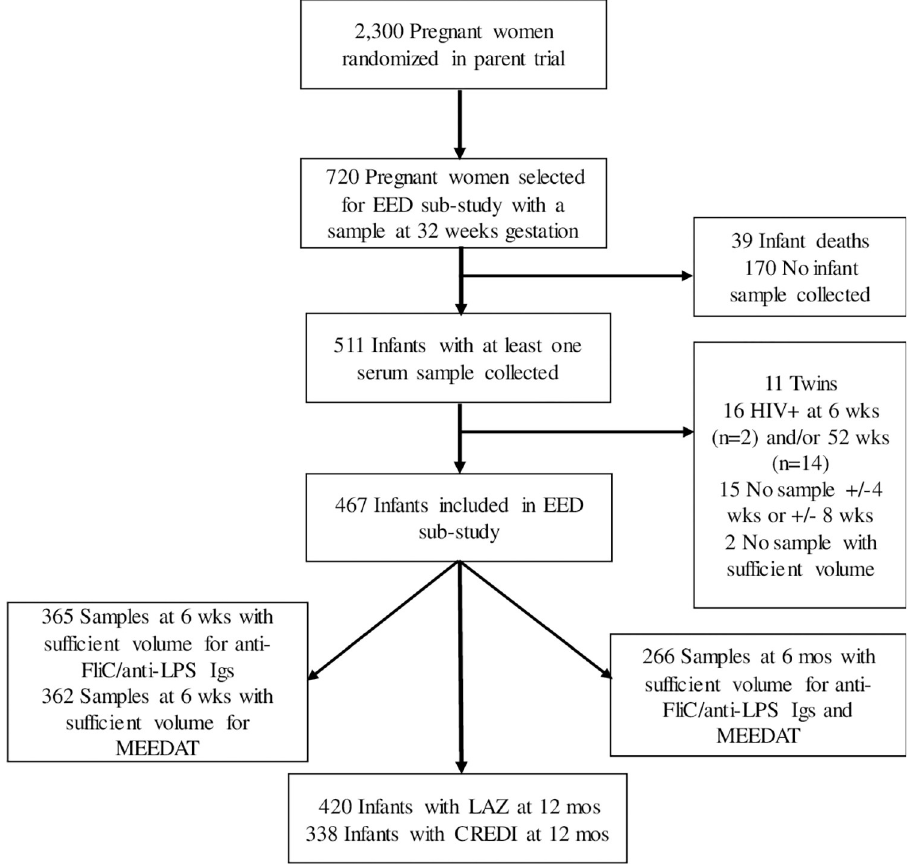
Fig 1. Flow diagram for study. Abbreviations: CREDI, Caregiver Reported Early Development Instruments; EED, environmental enteric dysfunction; FliC, flagellin; Ig, immunoglobulin; LAZ, length-for-age z-score; LPS, lipopolysaccharide; MEEDAT, Multi-Micronutrient and Environmental Enteric Dysfunction Assessment Tool Correlations among anti-flagellin and anti-LPS Igs were generally high, ranging from 0.736 between anti-flagellin IgG and anti-LPS IgG (p < 0.001) to 0.098 between anti-flagellin IgG and anti-LPS IgA at 6 weeks and from 0.853 between anti-flagellin IgA and anti-LPS IgA (p < 0.001) and 0.274 between anti-flagellin IgG and anti-LPS IgA (p < 0.001) at 6 months. MEEDAT’s EED biomarkers, sCD14 and I-FABP, were moderately correlated with each other (0.367, p < 0.001 at 6 weeks and 0.436, p < 0.001 at 6 months); sCD14 was also moderately correlated with the systemic inflammation markers, CRP (0.367, p < 0.001 at 6 weeks and 0.338, p < 0.001 at 6 months) and AGP (0.616, p < 0.001 at 6 weeks and 0.410 at 6 months). CRP and AGP were highly correlated with each other (0.715, p < 0.001 at 6 weeks and 0.688, p < 0.001 at 6 months). Overall, there was a low correlation between anti-flagellin and anti-LPS Igs and MEEDAT biomarkers.